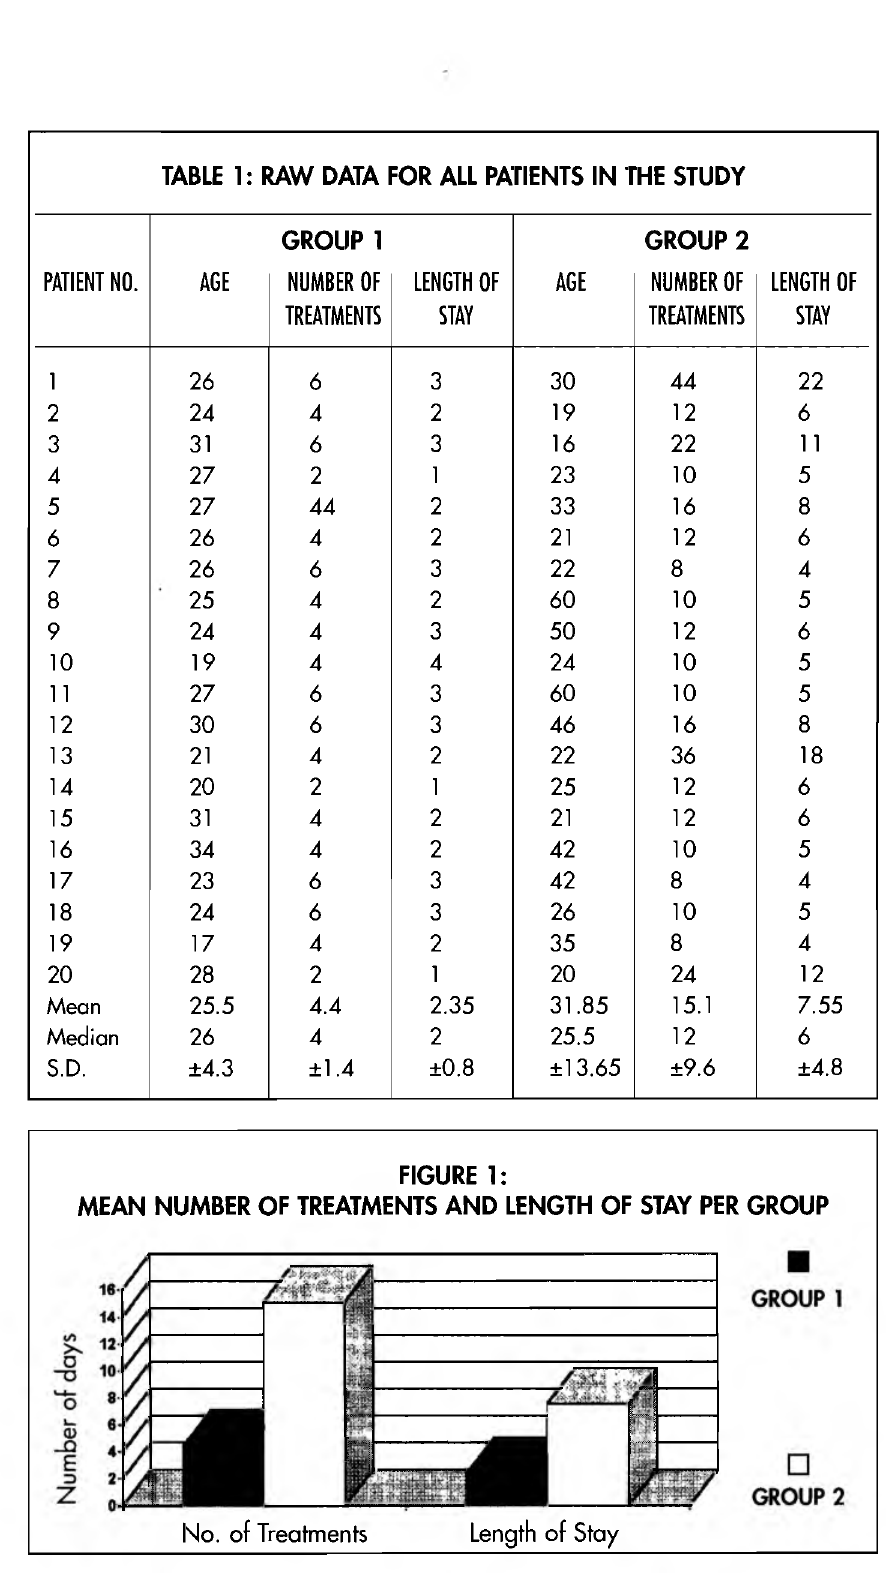
TABLE 1: RAW DATA FOR ALL PATIENTS IN THE